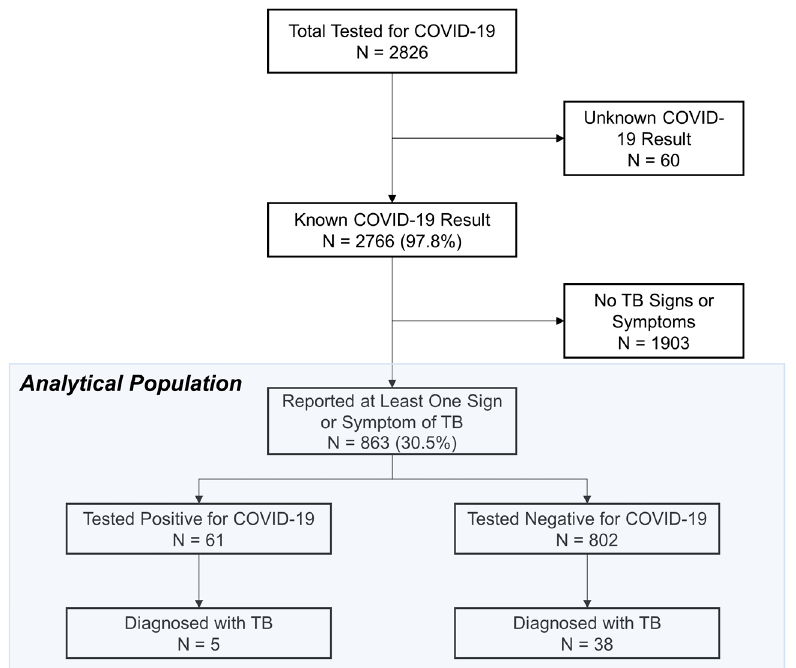
Figure 2. Study flow diagram. Table 2. Socio-demographic and clinical characteristics of individuals screened for TB/COVID-19 in Guinea and